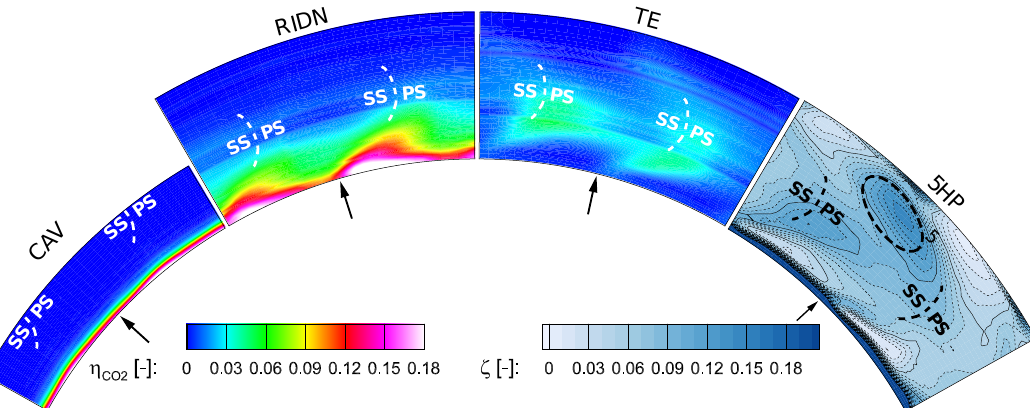
Figure 12. NGV exit plane, SWL, MFR 3, CAV-/RIDN-/TE-seeding and loss contours from 5HP measurements. Arrows indicate the swirler core